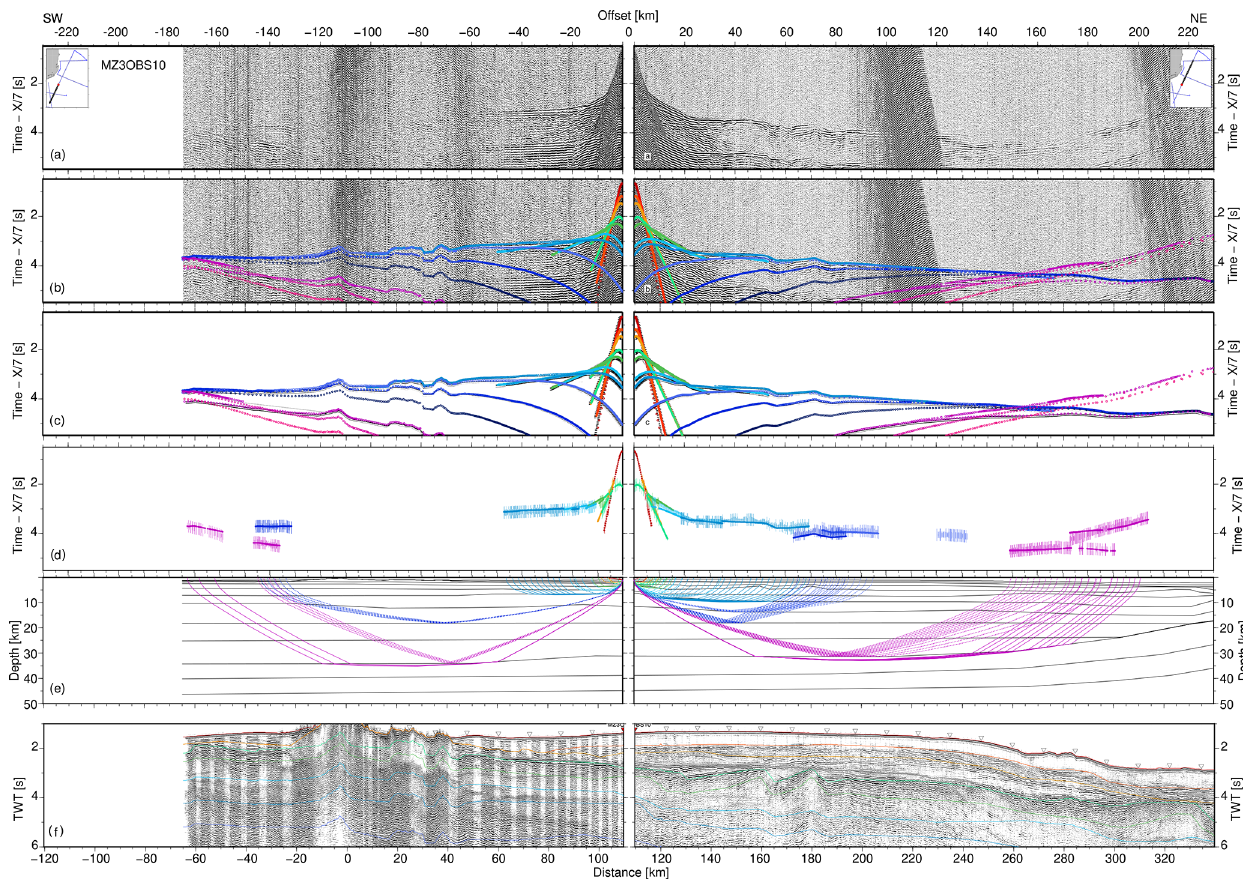
Figure 9. The same as Fig. 6 but for